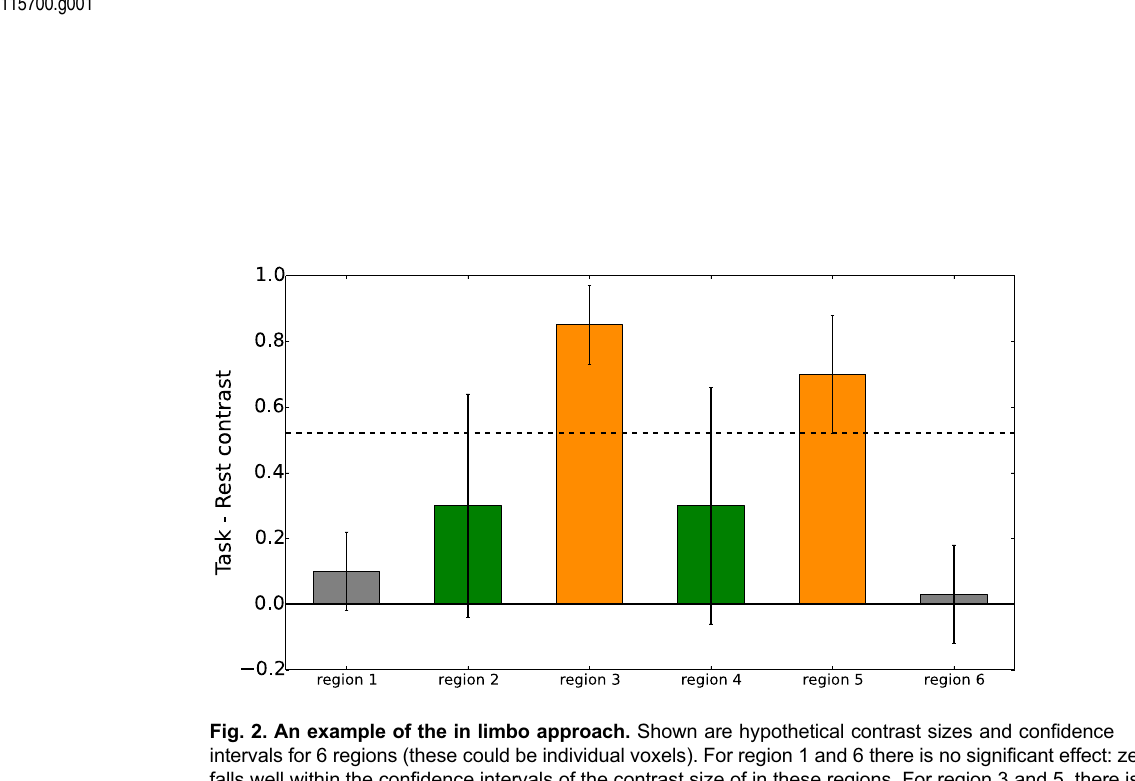
Fig. 1. Illustration of the imager’s fallacy: during the task condition, region 1 shows significantly increased activation as compared to the rest condition. Region 2 does not show significantly increased activation. One could be inclined to conclude that region 1 is selectively involved in the task. However, when the sizes of these contrasts are tested against each other, the size of the contrast in region 1 does not significantly differ from the size of the contrast in region 2.